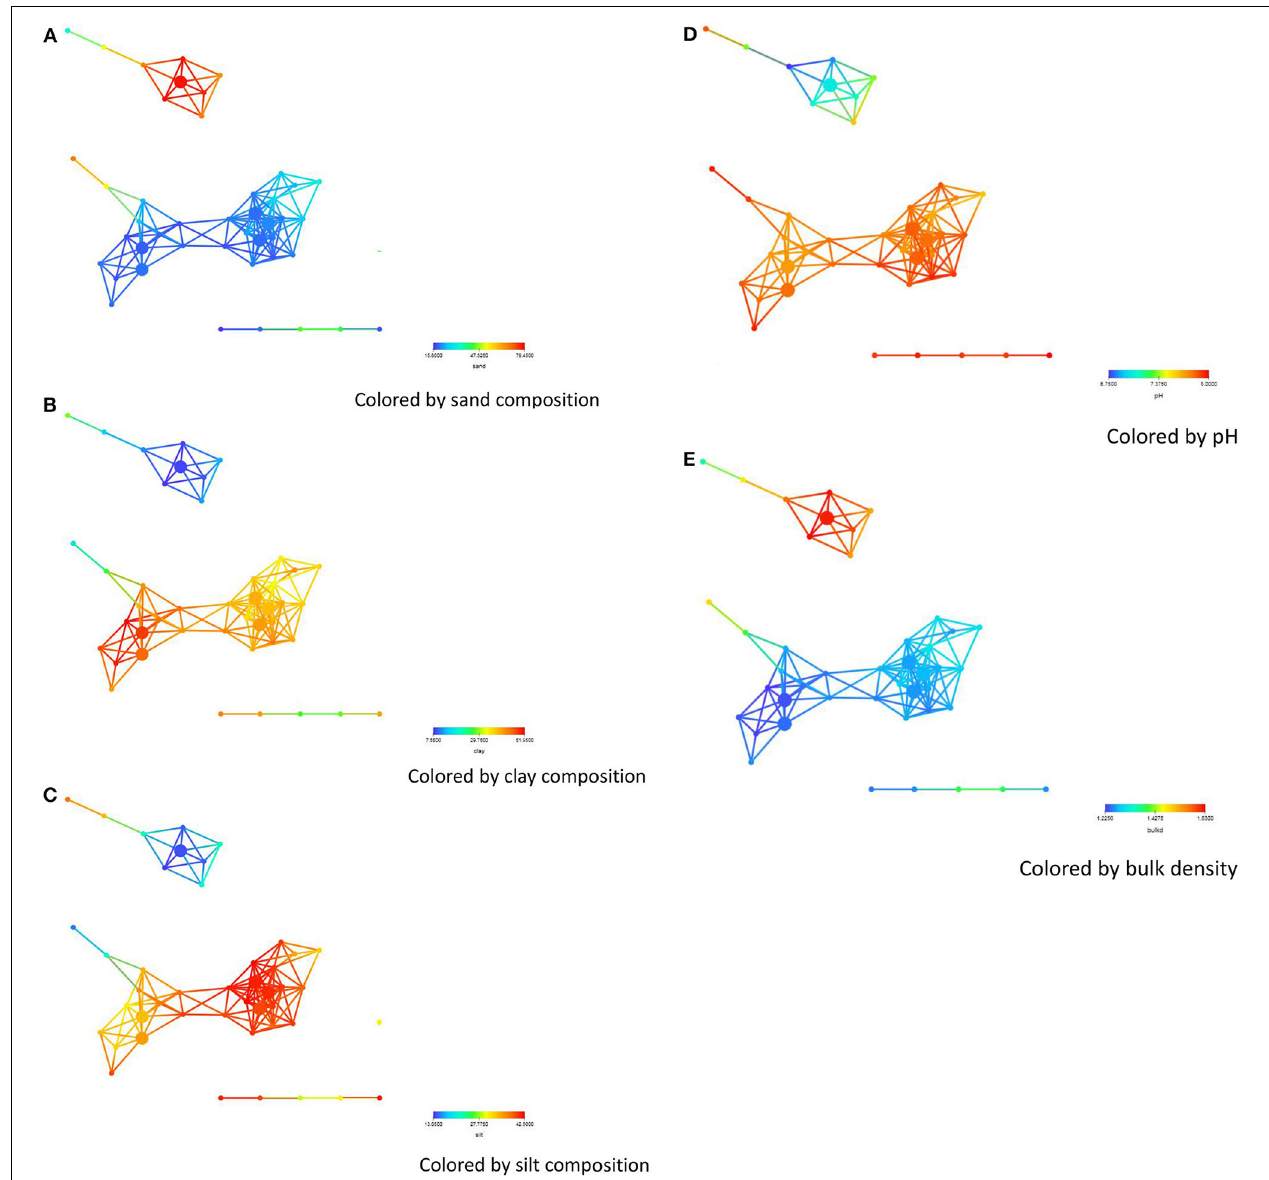
FIGURE 2 | Network colored by soil physical property concentrations-(A) sand, (B) clay, (C) silt, (D) pH, (E) bulk density. The legend below the figures shows ranges in concentrations of some of the soil physical properties. The distance metric and filters are as shown in the legend of Figure 1 .